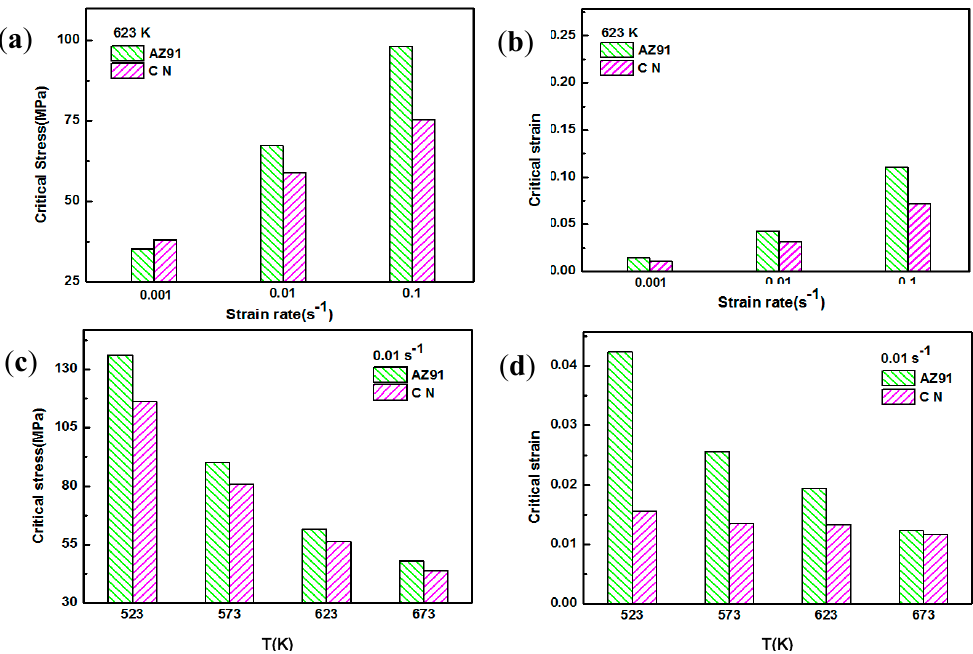
Figure 9. The critical stress and strain of AZ91 and nano-SiCp/AZ91 composite: ( a , b ) 623 K, ( c , d ) 0.01 s − 1 .